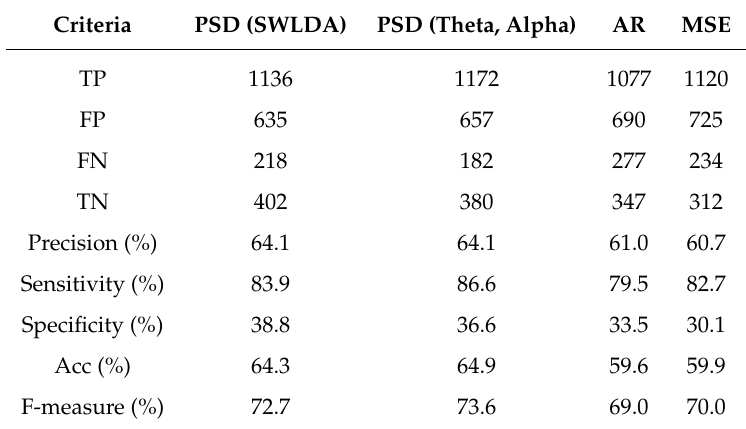
Table 2. Performance summary of alert vs. drowsy classifications when the threshold for the two classes was set to 5.